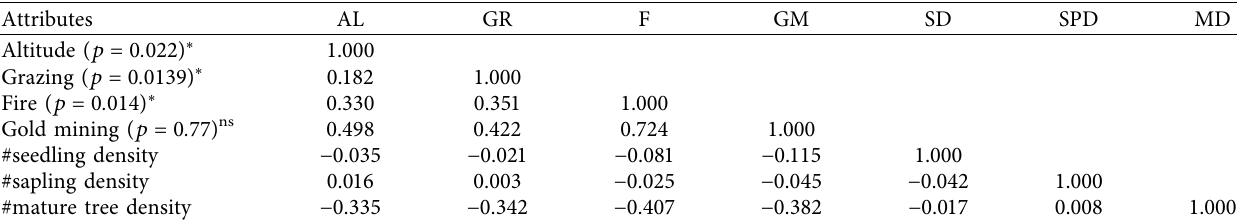
Table 6: Pearson correlation coefficient ( r ) between the density of seedling, sapling, and mature tree (stem · ha − 1 ) and environmental factors (human disturbances and altitude).